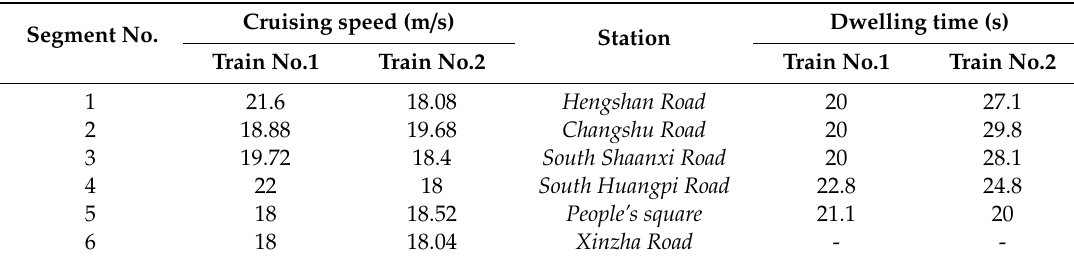
Table 1. Optimal selection by GA in the two-train network.